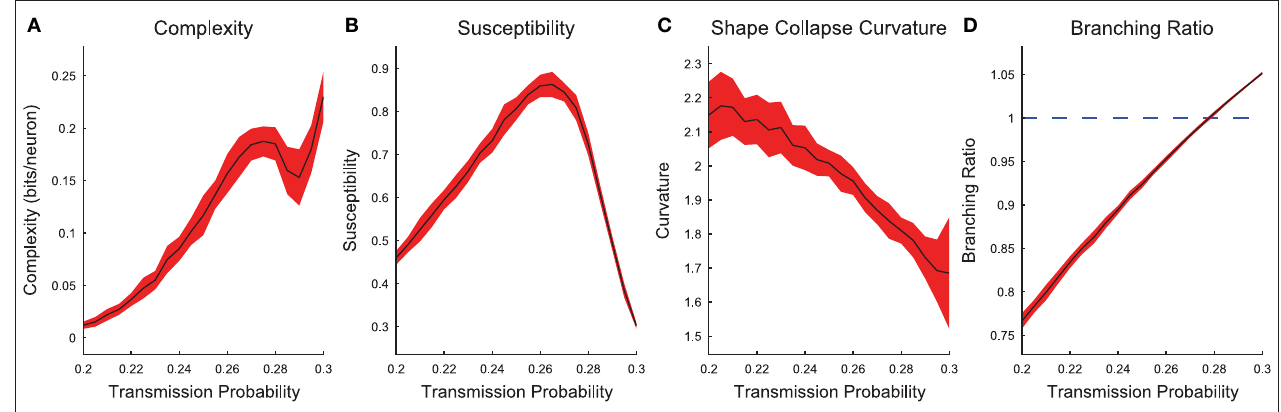
FIGURE 7 | Cortical branching models exhibit peaks in complexity and susceptibility, and branching ratios close to 1 near the infinite model critical point. (A,B) Complexity and susceptibility peaked near p trans = 0.25 indicating that both were maximized in critical systems. Note that complexity (A) also showed divergent behavior for high transmission probabilities. This behavior was due to finite recording length bias (Figure S2). (C) Shape collapse curvature did not peak near p trans = 0.25, though this was not expected. This indicates that low transmission probability avalanches were more curved and high transmission probability avalanches were more flat. (D) The branching ratios (Equation 13) of the networks were near 1 (critical state) near the transmission probabilities that showed peak complexity (A) and susceptibility (C) . In all sub-figures, the black line represents the average value and the red fringe represents ± one standard deviation.